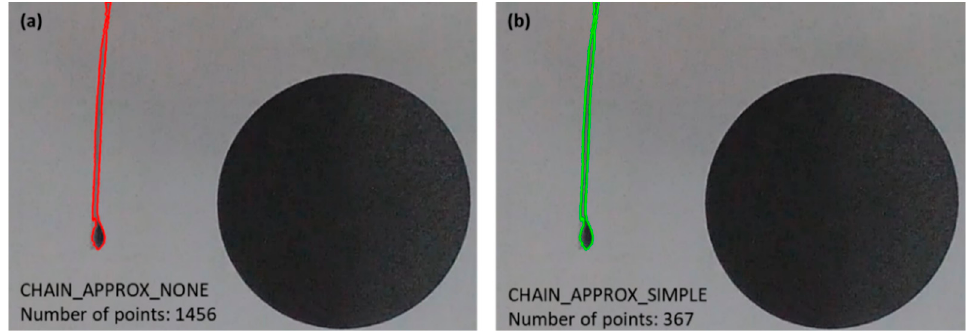
Figure 11. Sample contour approximation using ( a ) CHAIN_APPROX_NONE and ( b ) CHAIN_AP-